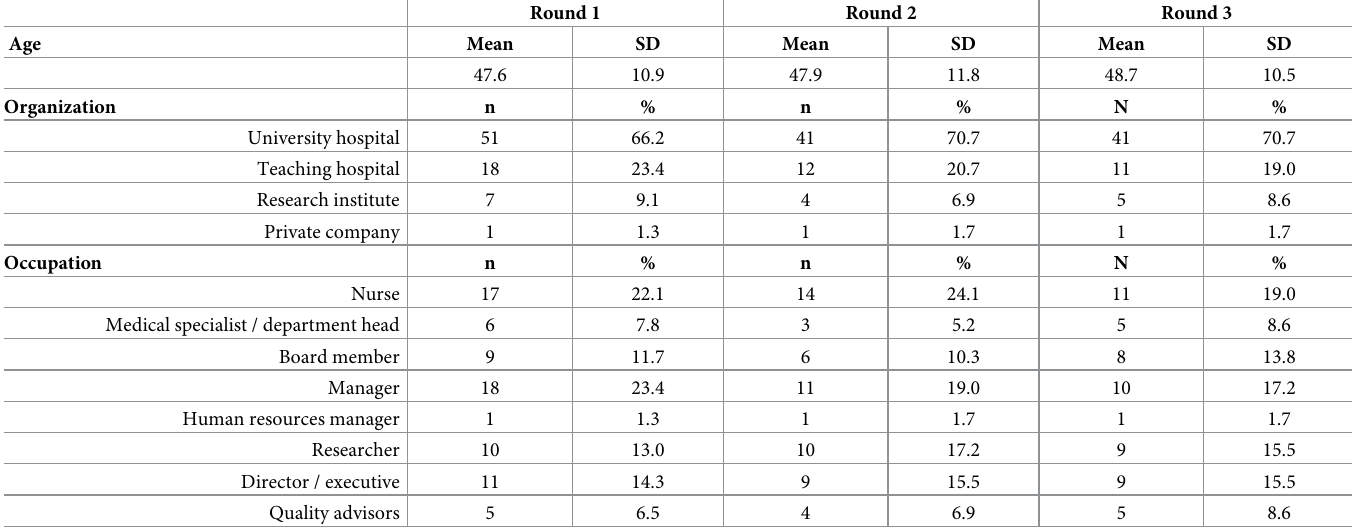
Table 2. Characteristics of Delphi